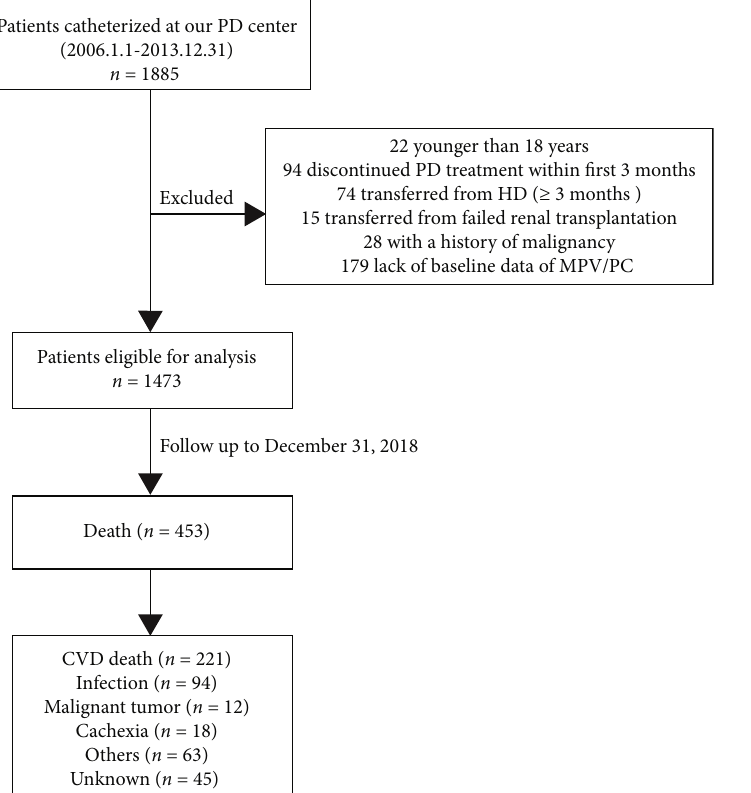
Figure 1: Flowchart of the participants in the study cohort. PD: peritoneal dialysis; HD: hemodialysis; MPV/PC: mean platelet volume to platelet count ratio; CVD: cardiovascular